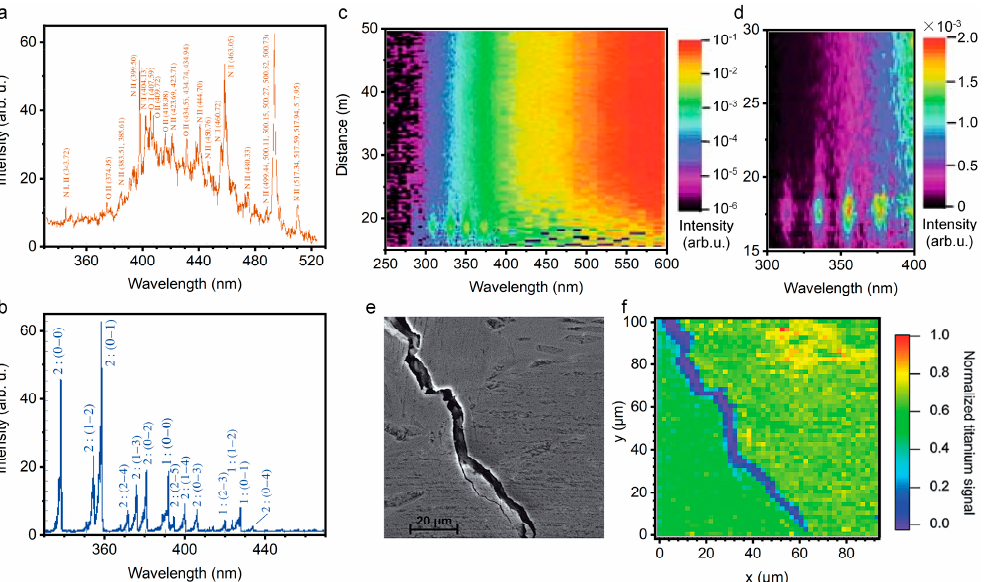
Figure 11. Filaments that were induced plasma spectroscopy. ( a , b ) Emission spectra of air in atmospheric pressure interacting with a Ti:Sapphire laser pulse of duration of 0.2 ns ( a ) and 200 fs ( b ) [187]; ( c , d ) intensity distribution of backscattered signal ( c ) and nitrogen fluorescence bands ( d ) from the filament as a function of the distance and the wavelength from filament [188]; ( e , f ) SEM graph ( e ) and FIPS map ( f ) of Ti–Al alloy surface [189].